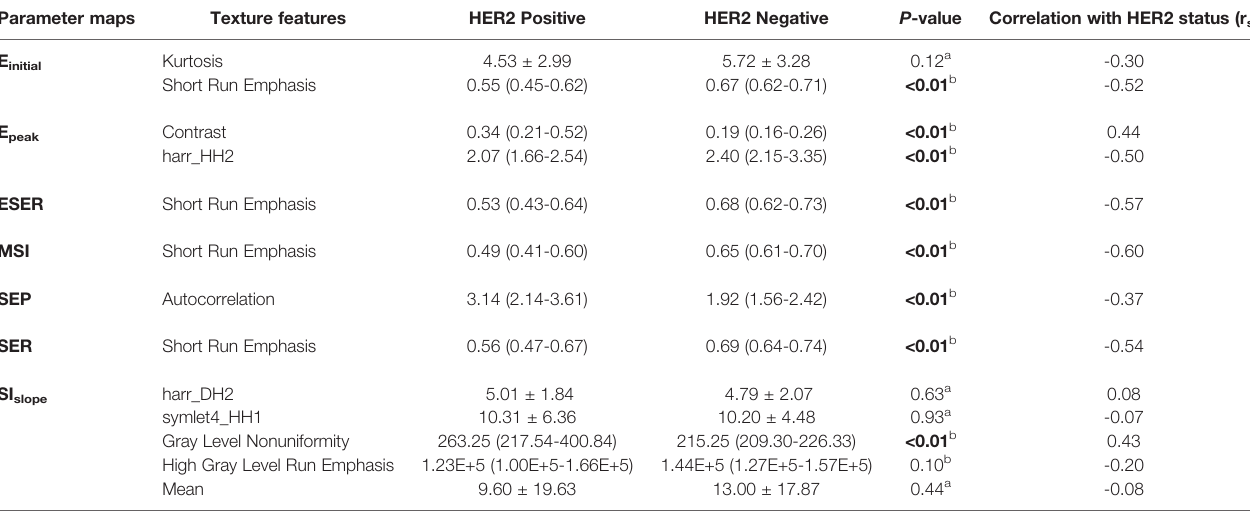
TABLE 5 | Comparison of texture features included in the logistic regression models in the training set between HER2-positive and -negative groups. Parameter